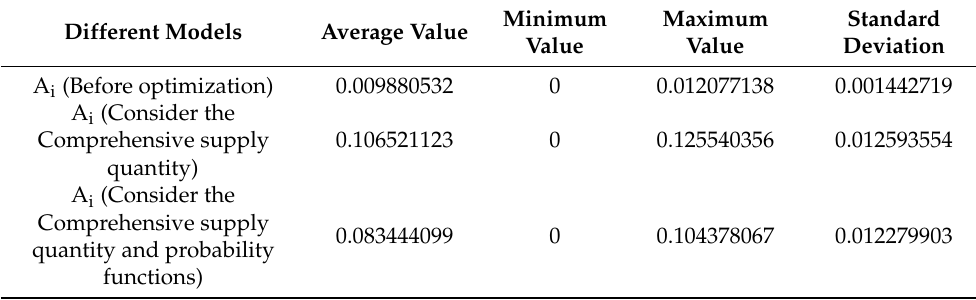
Table 4. Comparison of different